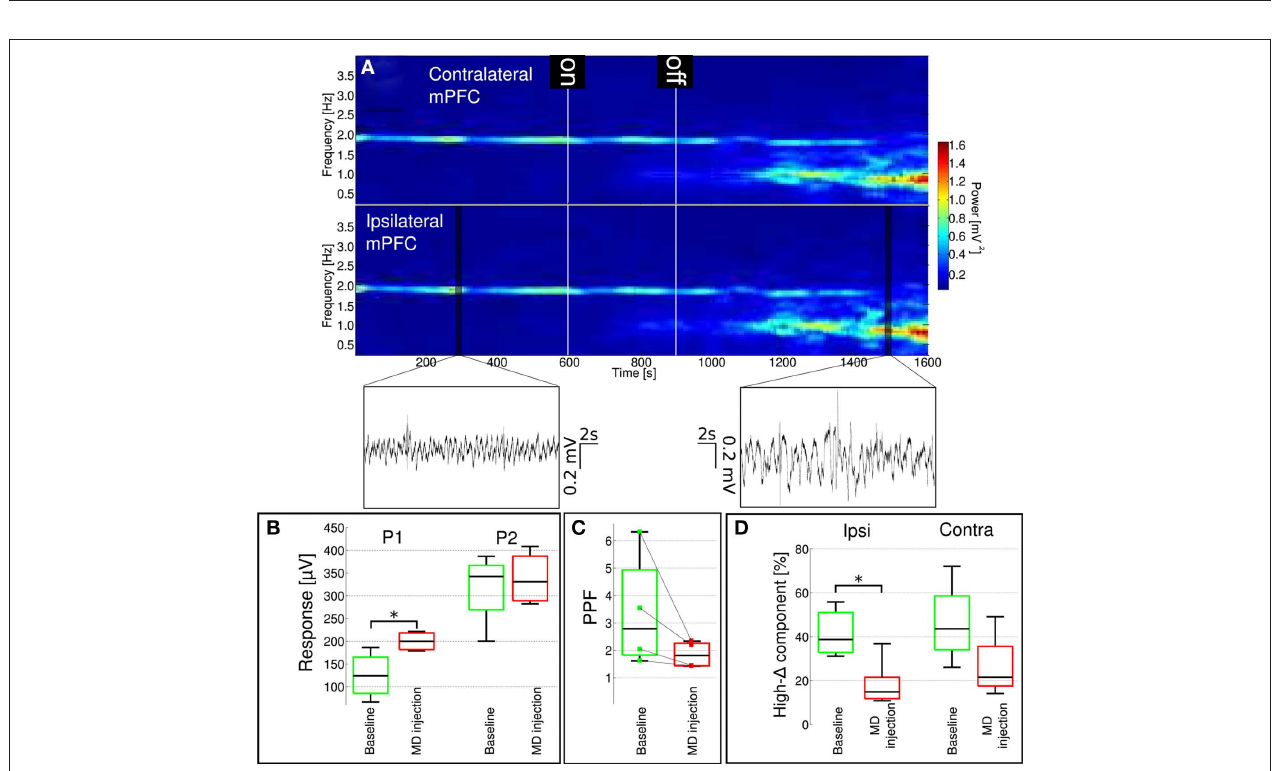
Figure 6 | MD cannula location. Stereotaxic diagram (left) and histological reconstruction (right) of the injection cannula (shown as a black bar on left) targeting the mediodorsal nucleus of the thalamus.